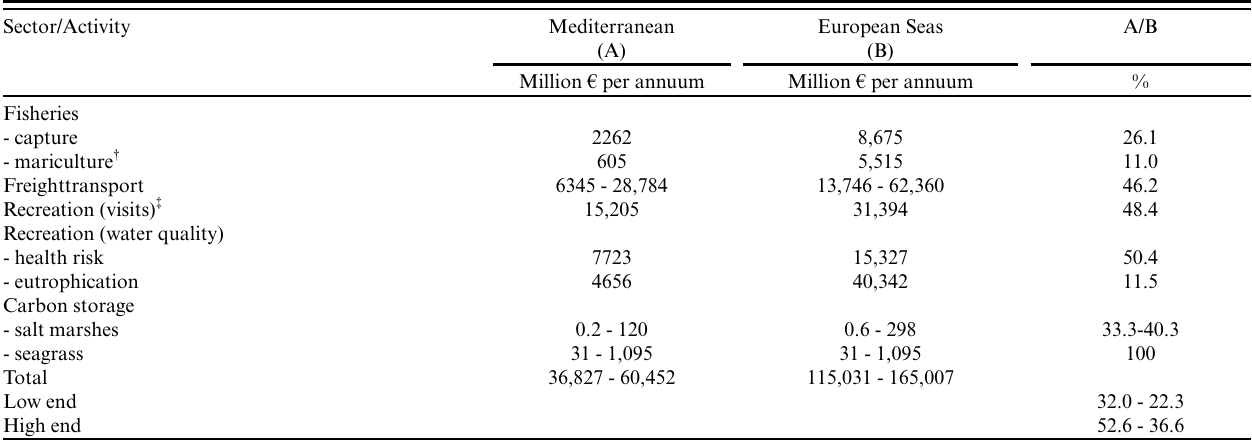
Table 4. Mediterranean share of current welfare benefits provided by European Seas (base year 2010; Data source: Cooper et al. 2011). The table shows that the value of the Mediterranean Sea space for freight transport is